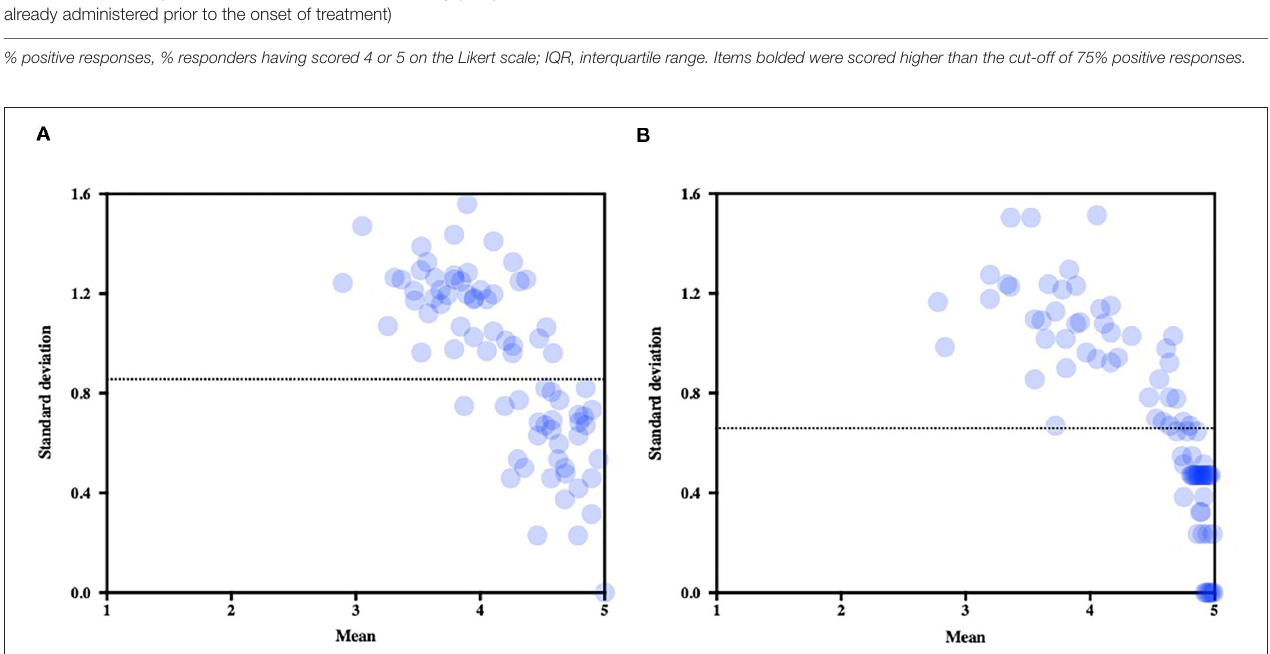
CoV = 0.160; Z = 514, p < 0.001). SD expressed